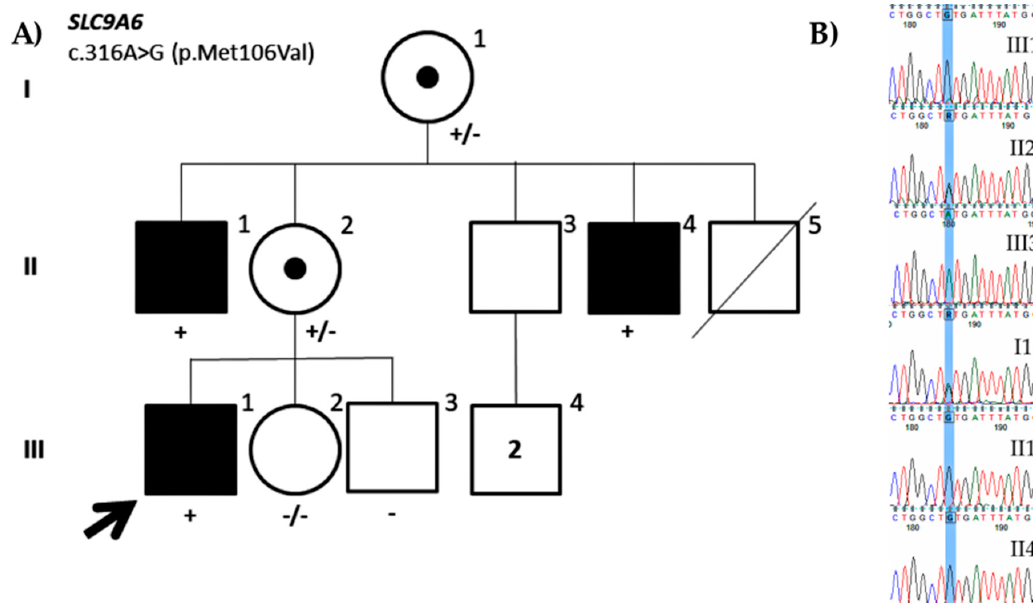
Figure 4. ( A ) Family pedigree of the ID0216 proband. Segregation of the missense variant identified in SLC9A6 (NM_001042537.1: c.316A>G; p.Met106Val). ( B ) Partial DNA sequence of the SLC9A6 gene. The identified nucleotide change is highlighted.